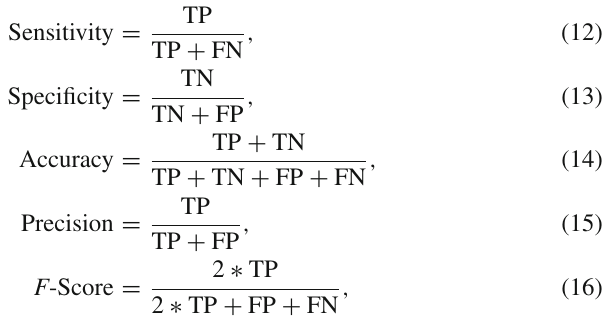
tion of truly genuine instances that are precisely detected by the system. Specificity denotes the ratio of correctly detected true positive and true negative samples. Accuracy estimates the correctness of the model, and Precision measures the amount of accurate classification done by the model, while F -Score is determined from Precision and